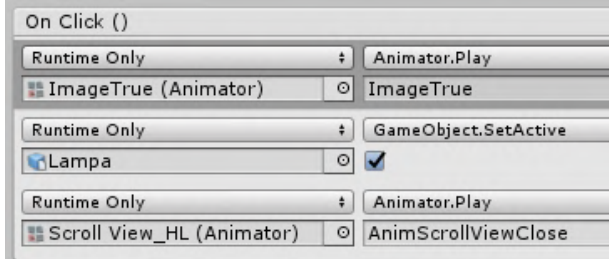
electric diagram. The electronic models of rheostat, amperemeter, voltmeter, current-controlled switch, lamp on pedestal and accumulator were uploaded to the diagram. All models, after being scaled up, were placed according to their symbols. By default, the models are inactive, that is invisible. Then, the Canvas component is added and the transparency of the Panel tool is set. Using the Button command in the Canvas right part, the buttons are added and the conventional symbols of the electric diagram elements superimposed on them. The displaying effect of ScrollView with equipment options is implemented by animation according to the above method. The equipment images in ScrollView are made via the Button command. Figure 10 shows the Button settings in section On Click () by the example of the correct answer.